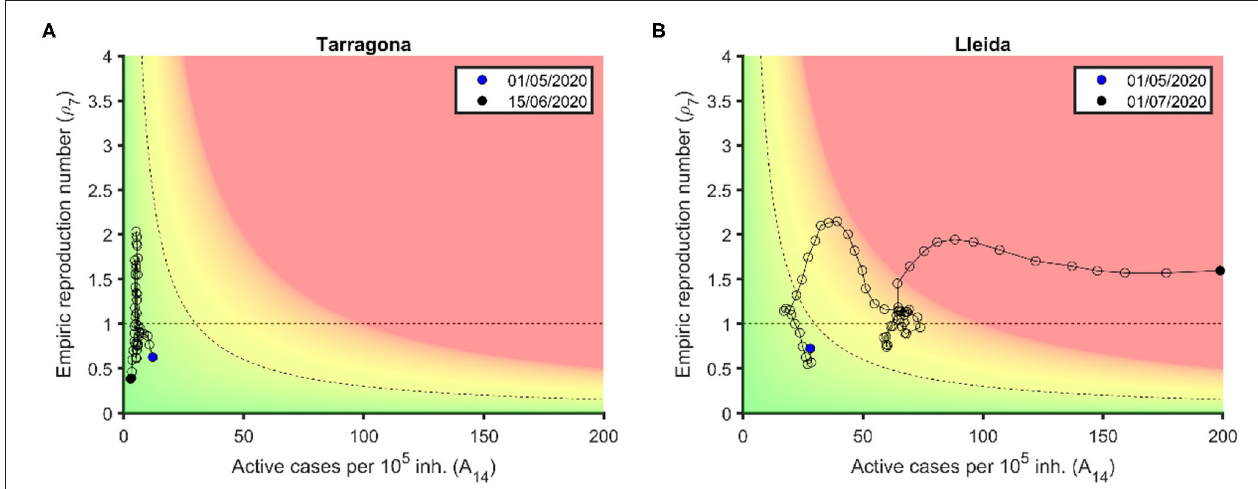
FIGURE 6 | Controlled and uncontrolled outbreaks in the risk. (A) Tarragona province: Two consecutive increases in ρ 7 occur in the green zone and can be controlled with simply test and trace. (B) Lleida province: An initial increase in ρ 7 occurs in the green-yellow zone and can be controlled through a slowing down of de-escalation process, while a second increase in ρ 7 enters the red zone and becomes an uncontrolled outbreak. Data are obtained from Datadista ( 27) and Instituto de Salud Carlos III ( 28) on October 23, 2020.